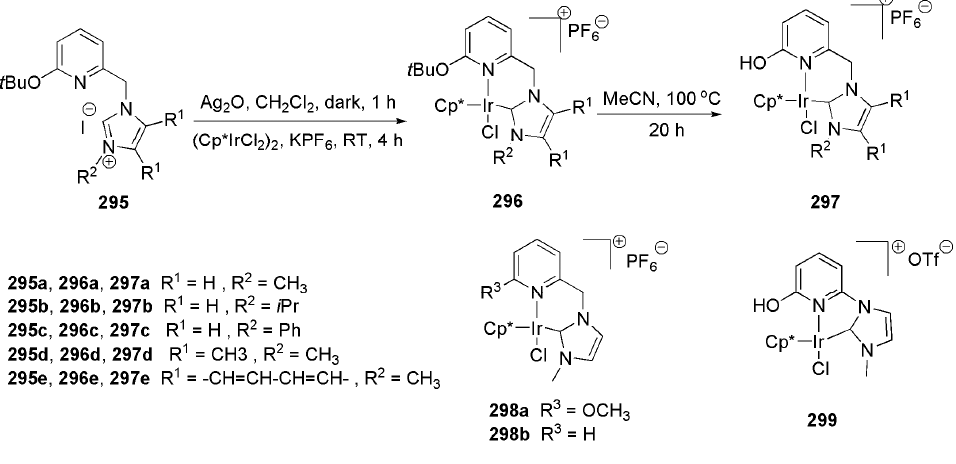
Scheme 74. Synthesis of Ir complexes [245]. Cp* = Me 5 ‐